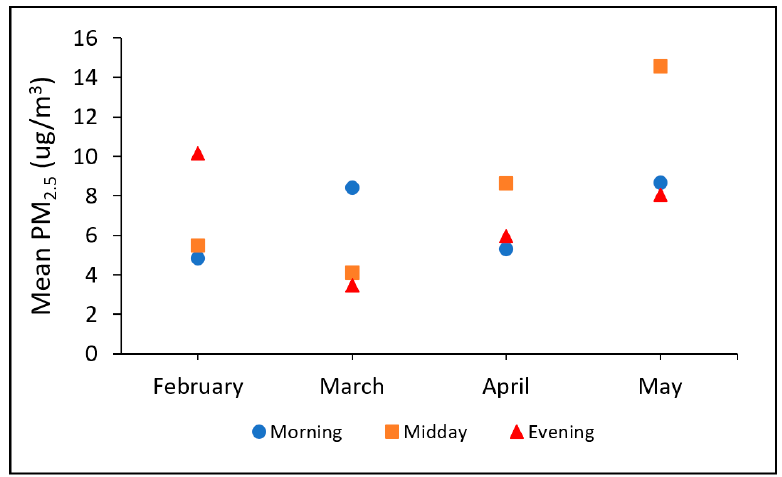
Figure 8. Average PM 2.5 concentrations across each monthly sampling day and each sampling time period.